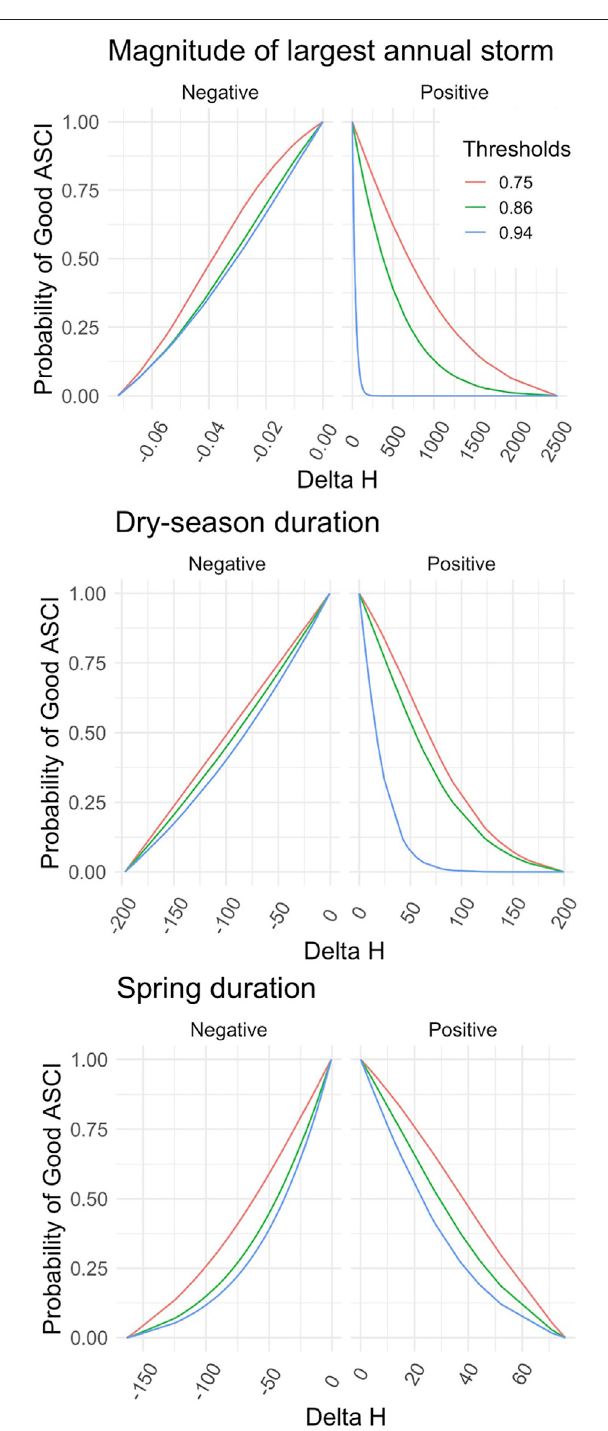
FIGURE4| Flow-Ecologyrelationshipbetweenprobabilityofachievinga healthyCSCIscoreandallchosenFFM.Eachthresholdreferstothe fi rst,10th and 30th CSCI score percentile, i.e., likely altered possibly altered and likely intact.